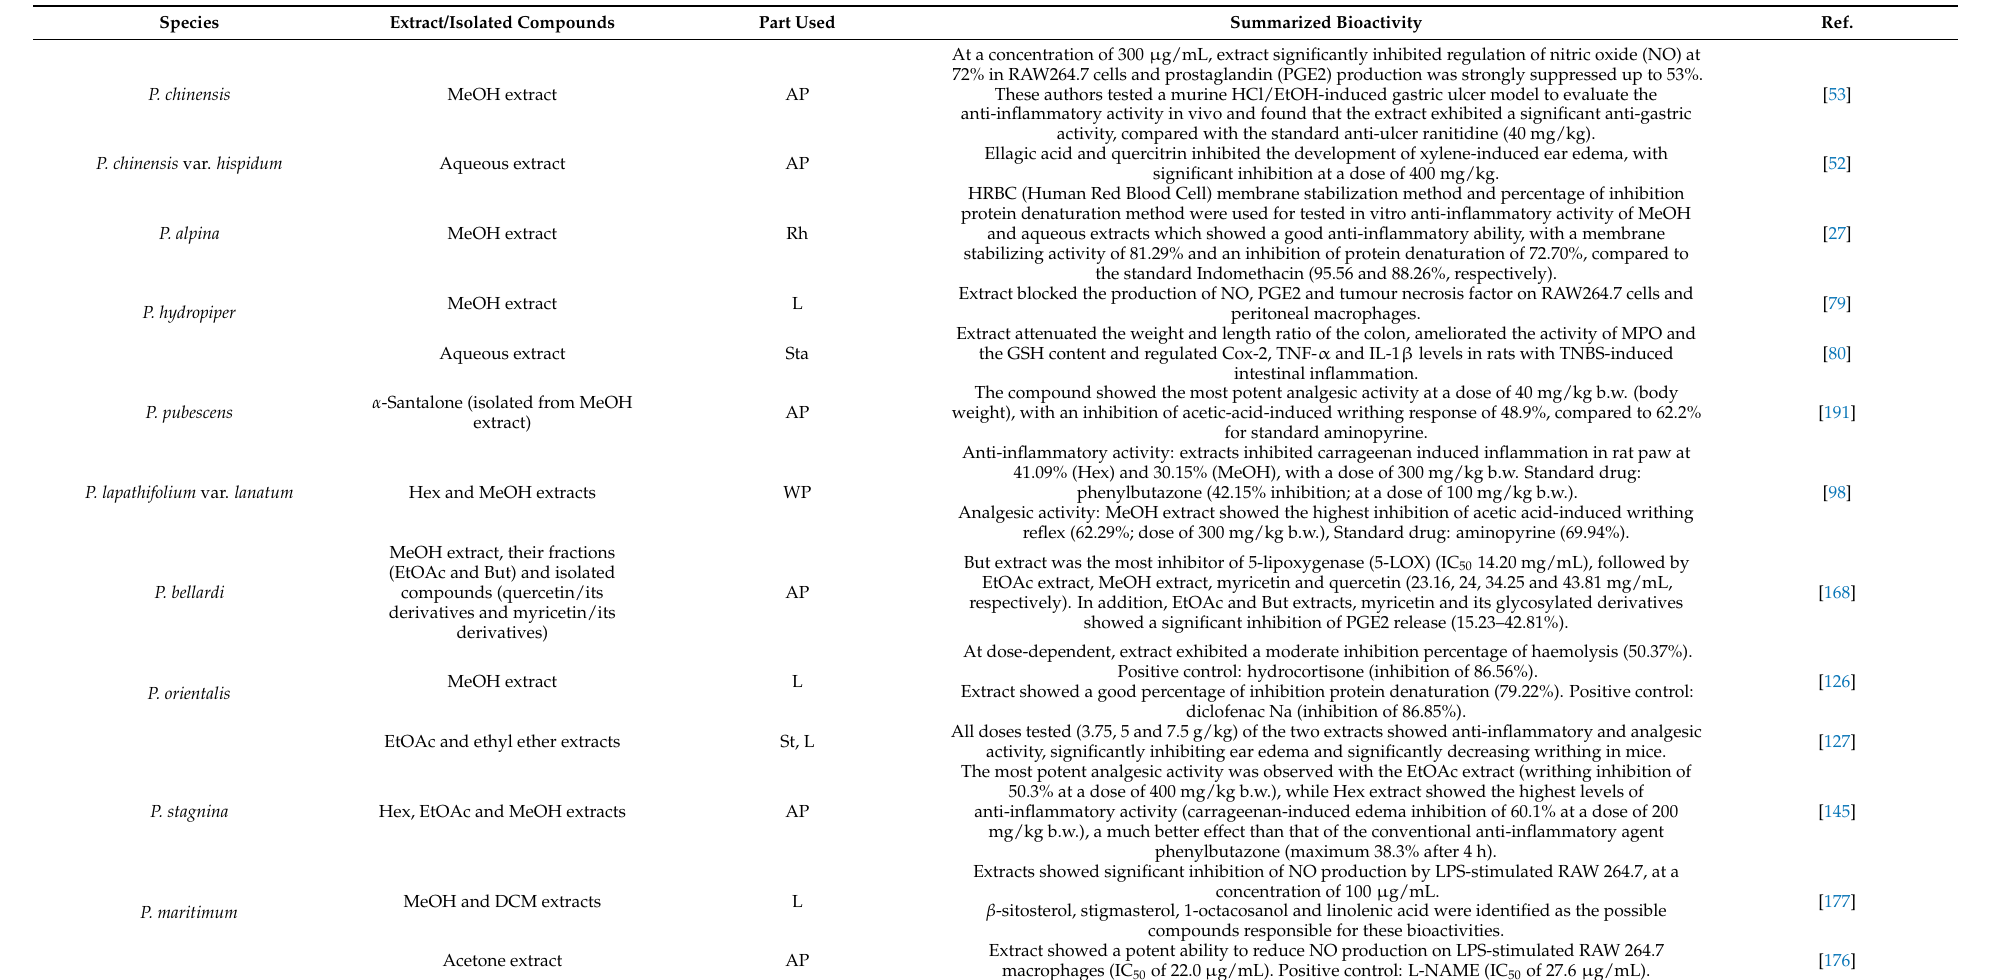
Table 4. Analgesic an anti-inflammatory activity of Persicaria and Polygonum species. Extracts, compounds, part of plant used, anti-inflammatory and analgesic activity with their references are shown. Extracts: DCM (dichloromethane); EtOH (ethanol); MeOH (methanol); Hex (hexane); EtOAc (ethyl acetate); But (butanol). Part used: L (leaves); St (stems); Rh (rhizomes); Sta (stalks); WP (whole plant); AP (aerial